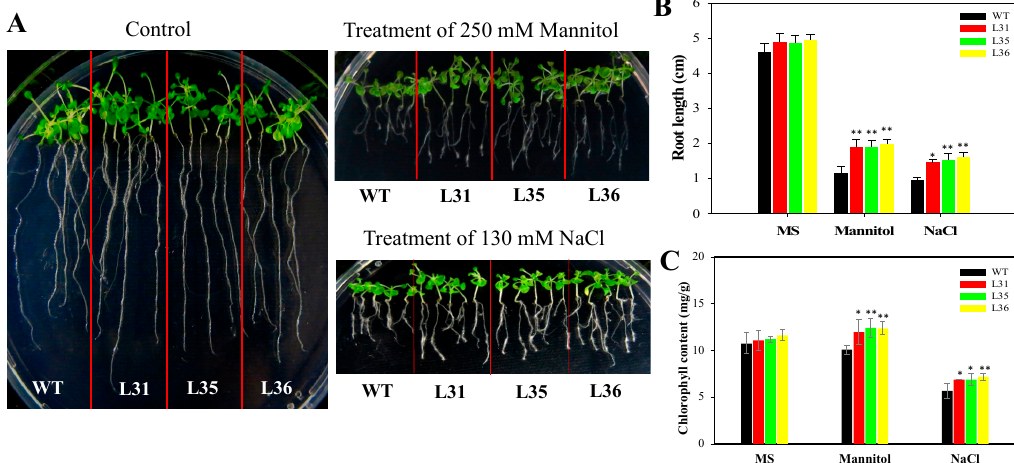
Figure 6. The effect of osmotic stress on seedlings of VqSTS36 transgenic Arabidopsis seedlings. ( A ) Five-day old transgenic (L31, L35, and L36) and untransformed seedlings were transferred from MS plates to new MS plate, MS supplemented with 130 mM NaCl, 250 mM mannitol. Representative images were taken. ( B ) Root lengths were measured 7 days after the initiation of osmotic stress treatment. ( C ) 7 days old VqSTS36 transgenic (L31, L35, and L36) and WT seedlings were transferred from the MS medium to an MS medium supplemented with 250 mM mannitol, 130 mM NaCl, and chlorophyll content was assessed 7 days following the initiation of osmotic stress treatments. Data represent mean values ± SD from three independent experiments. Asterisks indicate significant differences between WT and transgenic lines as determined by Student’s t -test (* 0.01 < p < 0.05, ** p < 0.01).